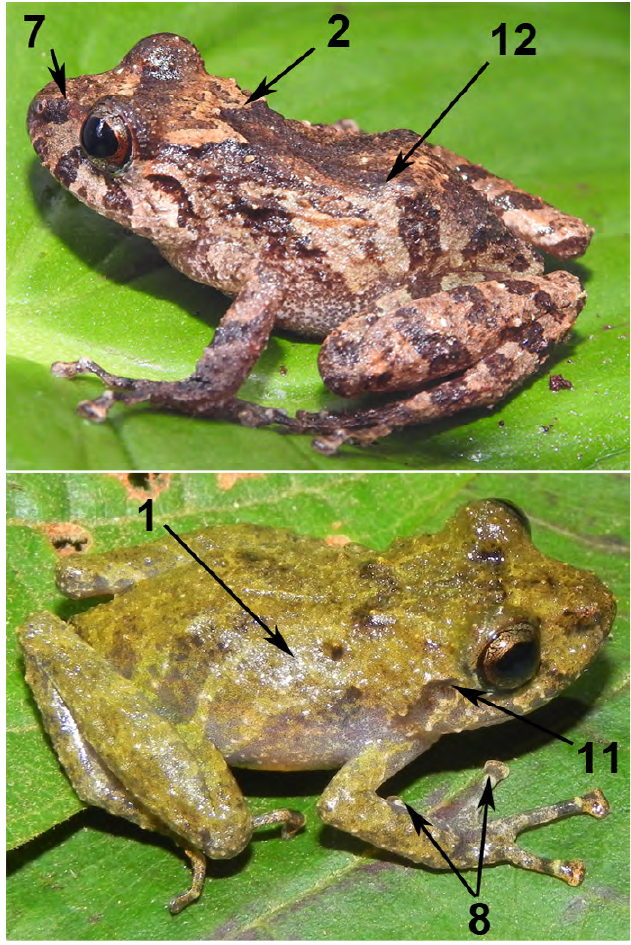
Figure 1 . Pristimantis ockendeni, Madidi National Park. Annotated numbers correspond to those featured in the description. Photos by M.